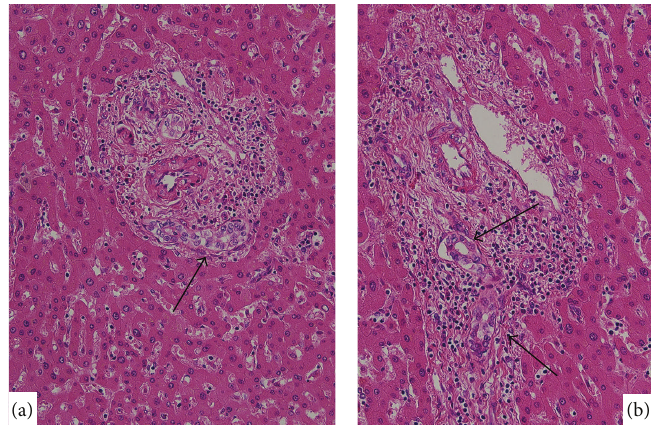
Figure 5: Atypical small bile duct lesion. (a) Small interlobular bile duct shows cellular and nuclear atypia. HE. (b) Small interlobular bile duct shows nuclear atypia and disturbed polarity. HE.